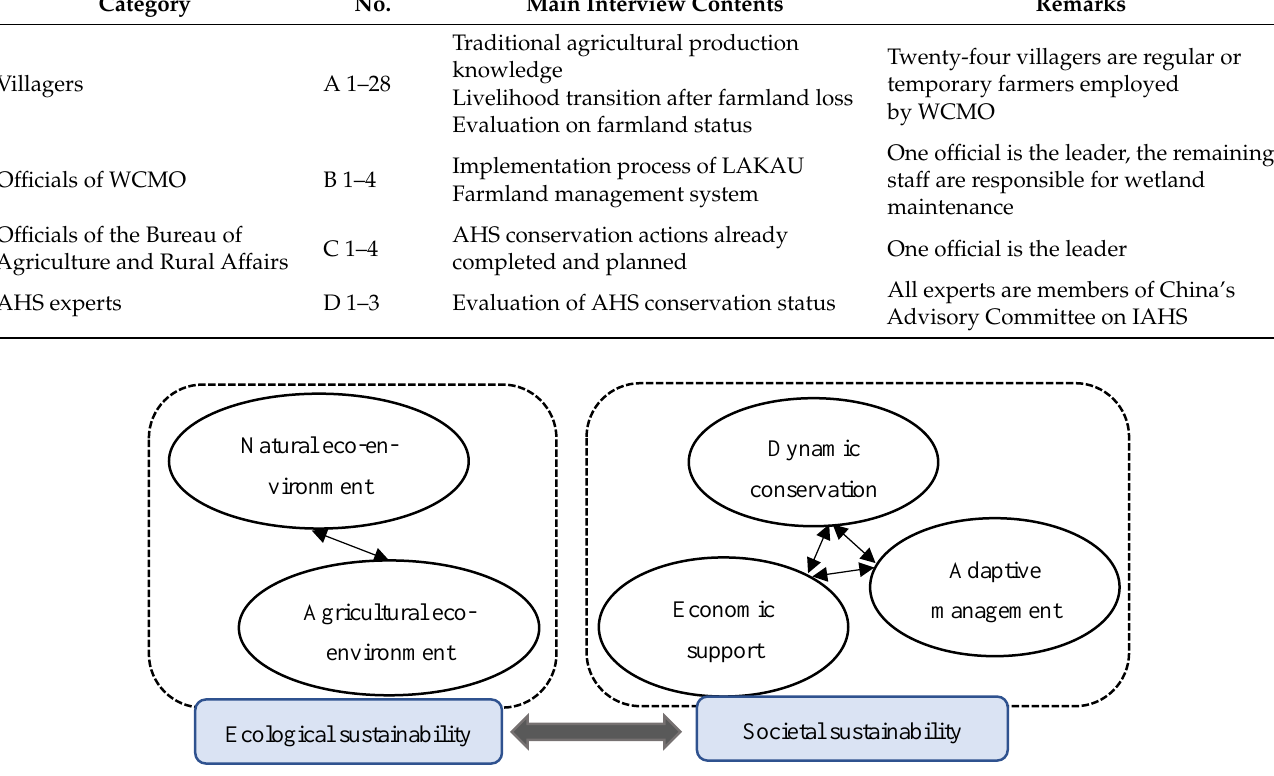
Figure 3. Framework for assessing intra-urban AHS sustainability.